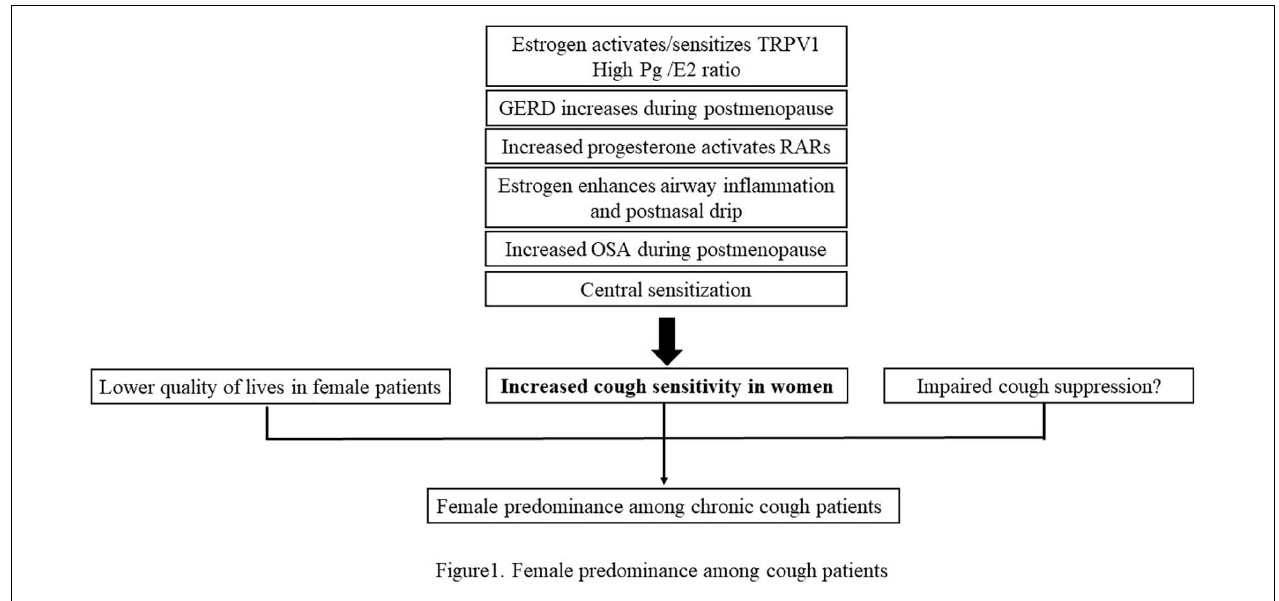
FIGURE 1 | Female predominance among cough